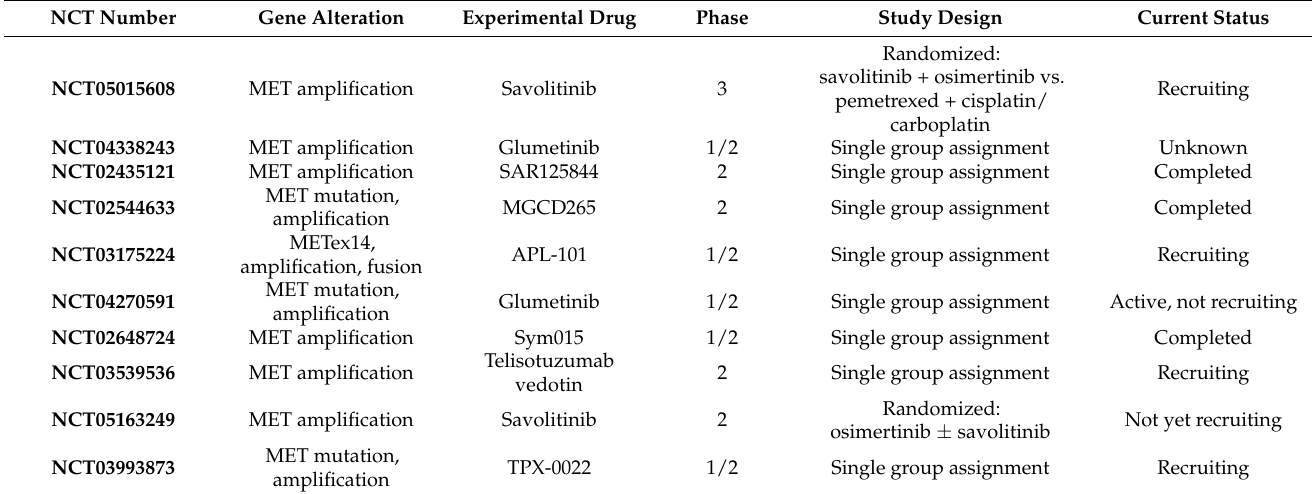
Table 2. A selection of clinical trials testing novel strategies to target MET altered